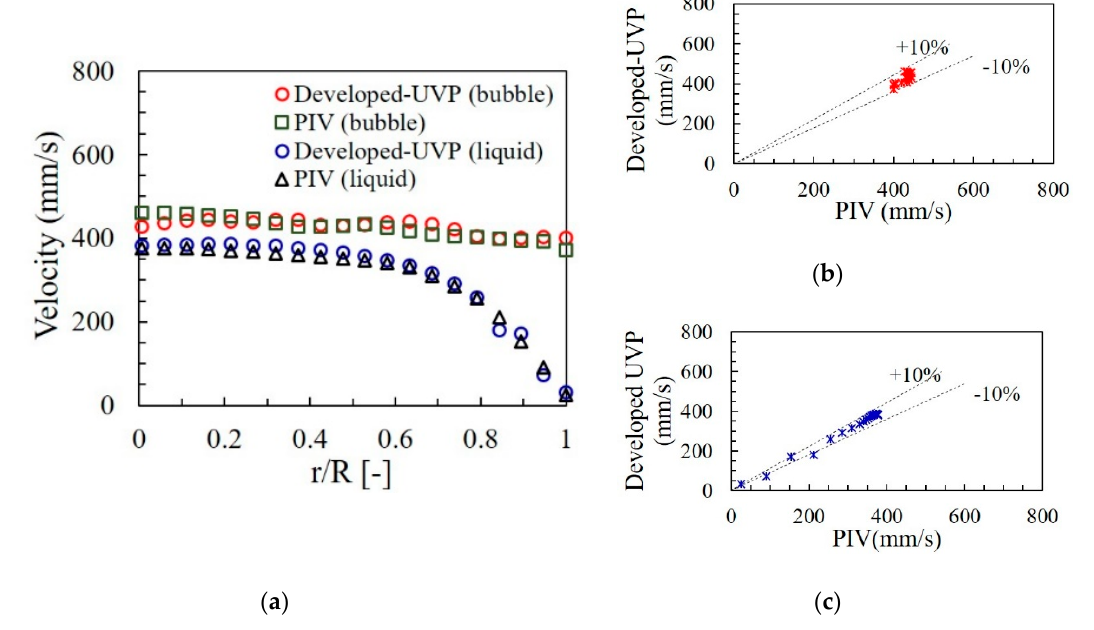
Figure 17. Average liquid and bubble velocity distribution in bubbly flow at U L = 300 mm/s and U G = 5.3 mm/s; ( a ) velocity profile, ( b ) discrepancy of bubble velocity, ( c ) discrepancy of liquid velocity.